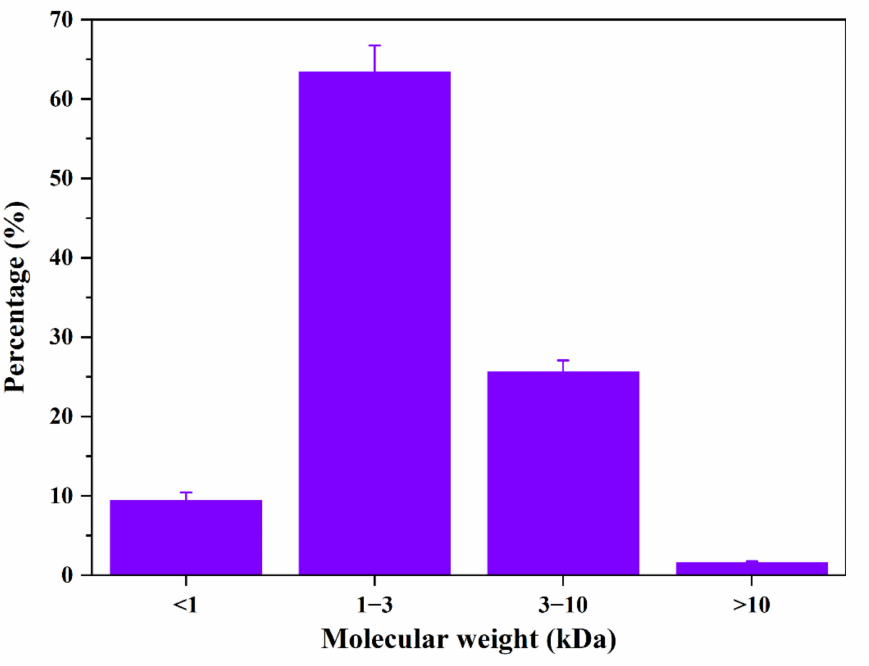
Figure 3. The molecular weight distribution of APT.